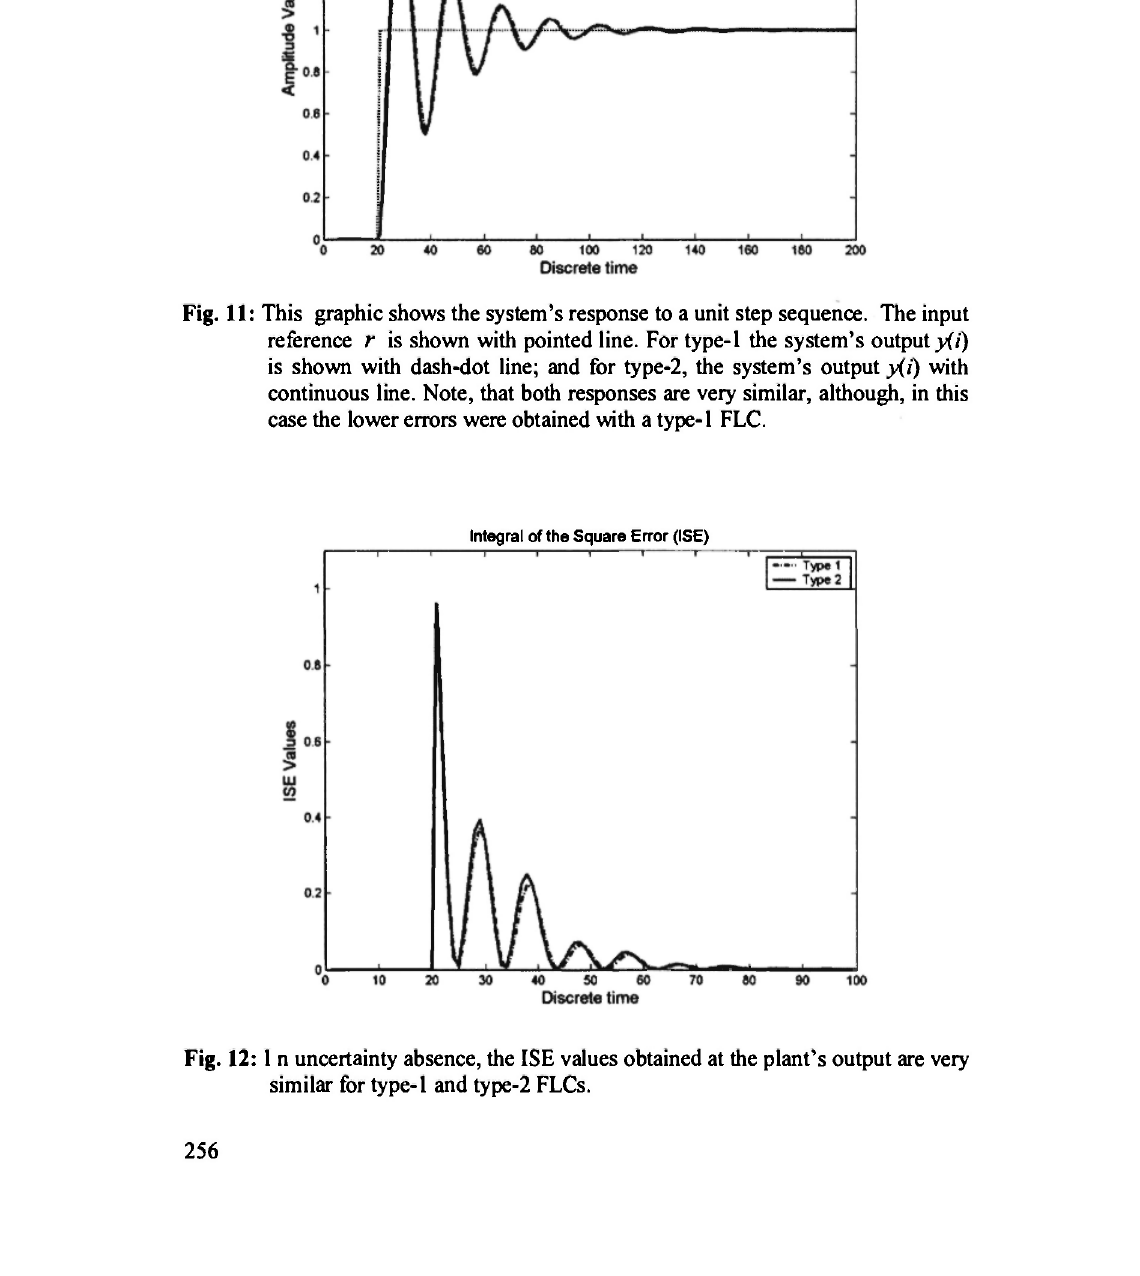
Fig. 12:1 η uncertainty absence, the ISE values obtained at the plant's output are very similar for type-1 and type-2